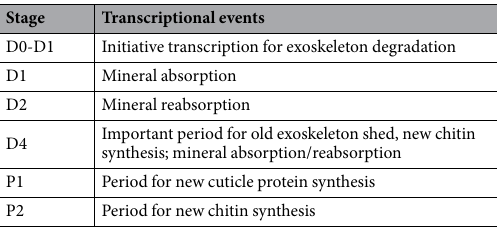
Table 5. A summary of transcriptional events applicable to the early development and moulting cycle in L.